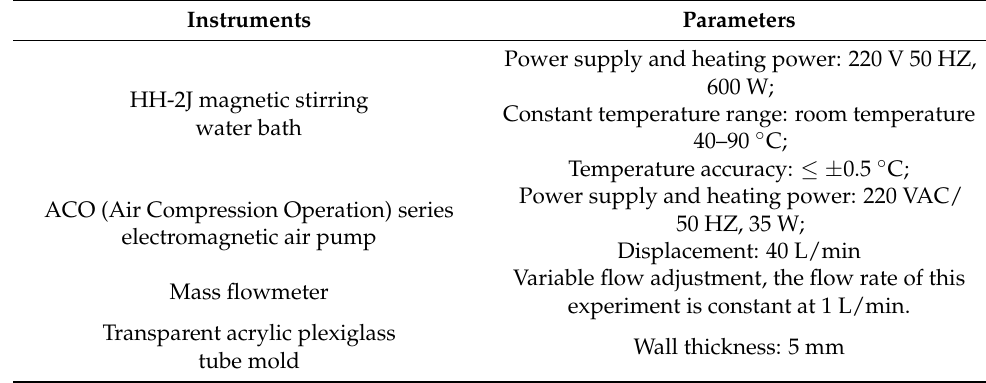
Figure 8. Changes in density and viscosity with the temperature of the No. 11 lubricating oil. Table 4. Main instruments and parameters of physical model verification